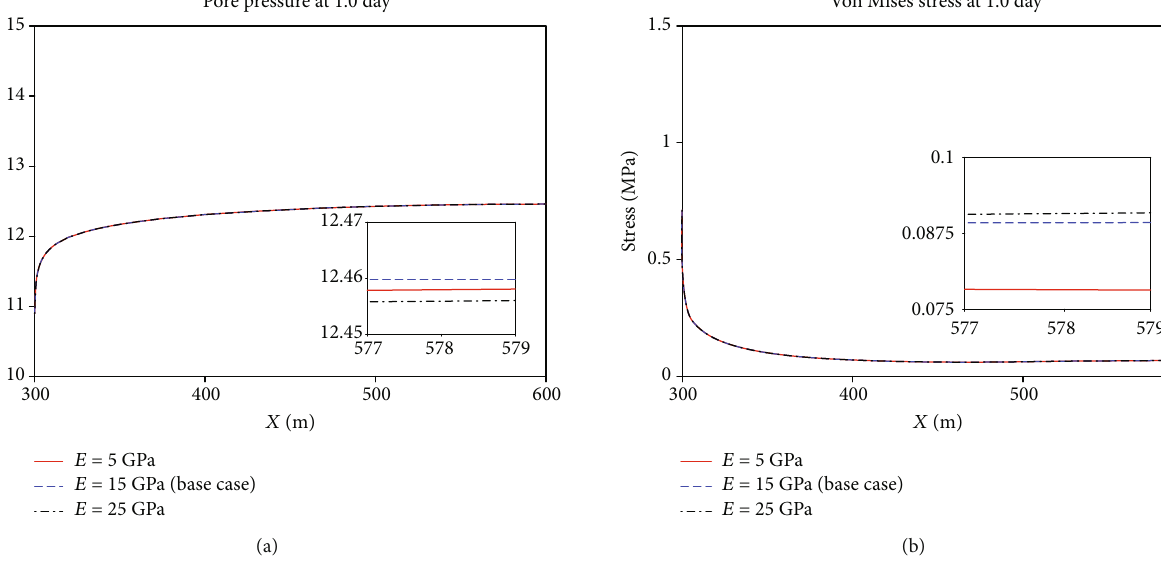
Figure 17: 1D (a) pressure and (b) stress distributions from the wellbore to the domain boundary along Y = 300m after 1 day of shallow water fl ow for Young ’ s modulus